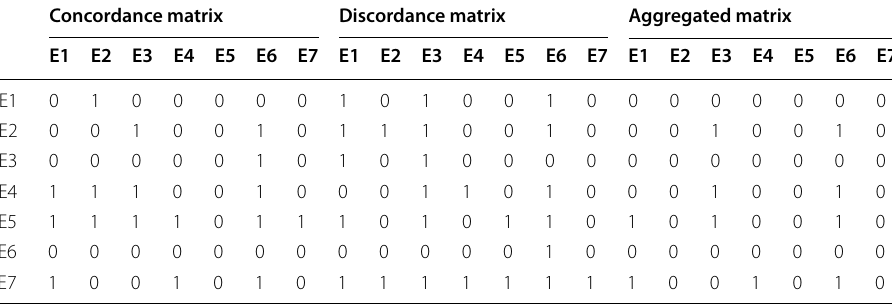
Table 24 Concordance, discordance and aggregated index matrixes Concordance matrix